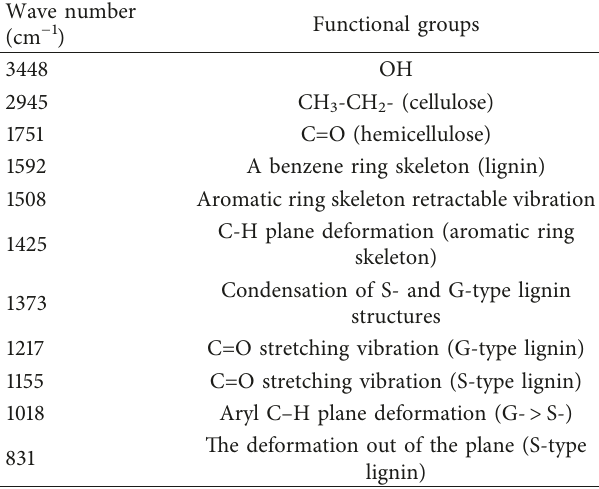
Table 2: The FTIR bands of